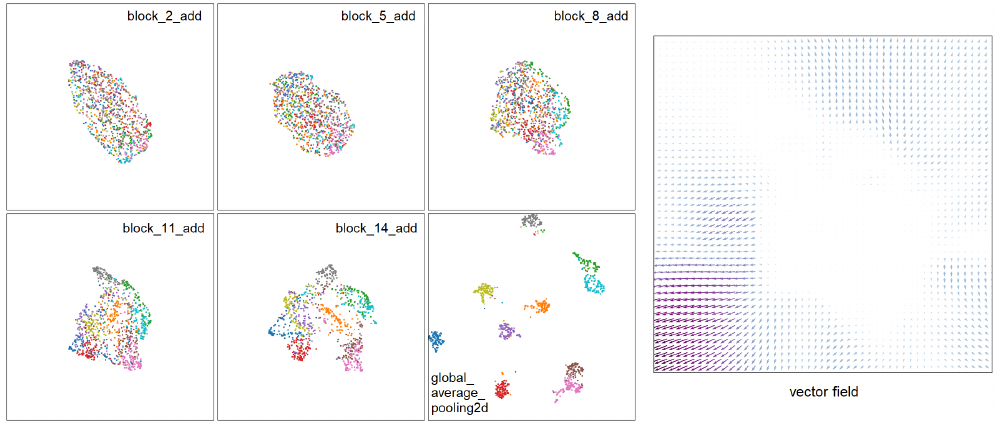
Figure 8. Projected sequential output data from six hidden layers of pre-trained MobileNetV2 using 1000 ImageNet inputs. Projections are shown in left-to-right, upper-to-lower order. It is possible to notice that, while still concentrated in the middle area in the first upper projections, points are slowly separated into classes before finally expanding in the last two projections. On the right side is the generated vector field. A high concentration of movement in all directions in the middle area makes the resulting field rather muted, but its intensity increases in outer areas of the